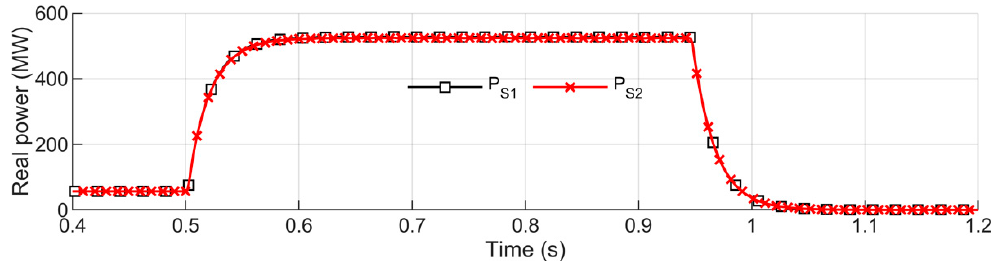
Figure 26. Currents in HTS cables in case DCR and DOCR fail: ( a ) HTS 1 ; ( b ) HTS 2 .